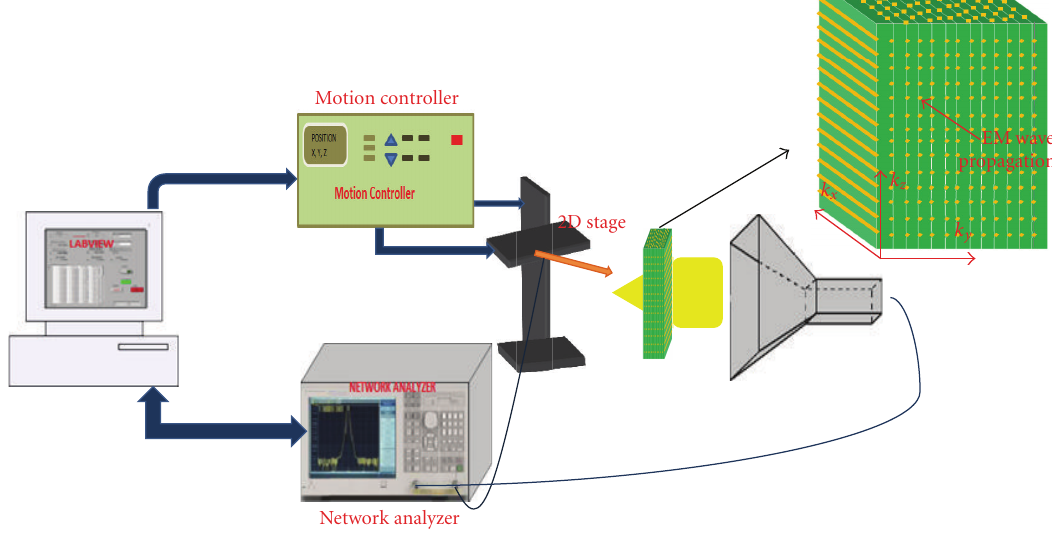
Figure 5: Schematic diagram of the experimental setup for superfocusing in the